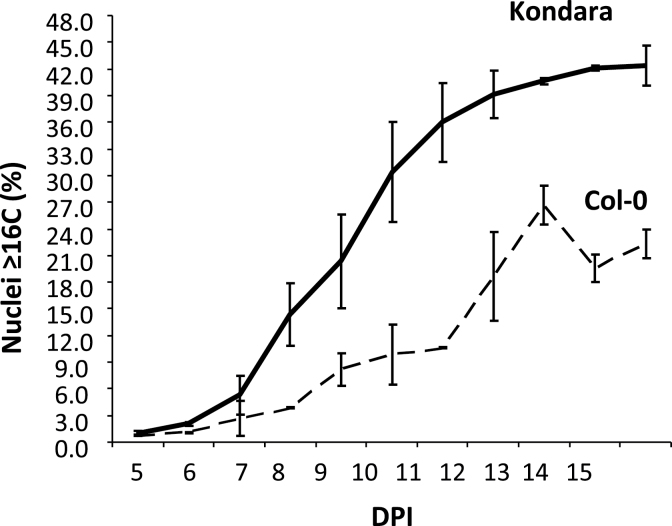
Advanced progression of successive endocycles in Kondara. The developmental series corresponds to days post initiation (DPI) of the fifth rosette leaf. Values are mean percentage ± standard deviation of three biological replicates of the endoreduplication fractions that correspond to 16C and above (see also Supplementary Fig. S1 available at JXB online). Time points between 8 and 15 DPI are significantly different in pairwise comparisons between Kondara and Col-0 (two-tailed t-test, P < 0.05).